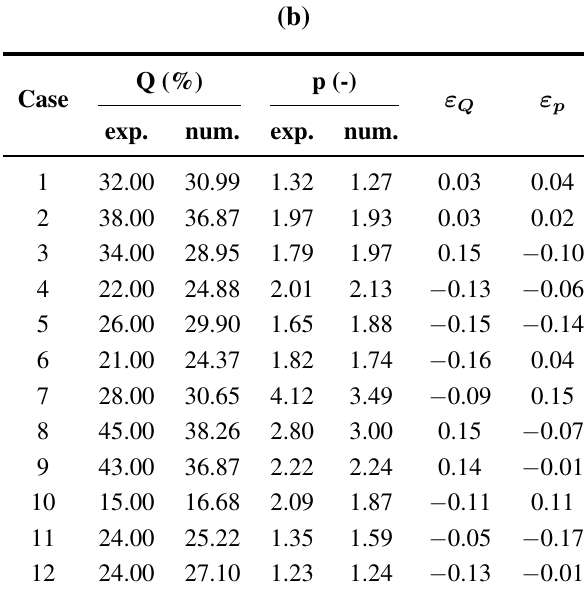
Figure 17. Specification of overtopping test cases. ( a ) Parameters; ( b ) tank and bund nomenclature [48]. Table 3. Simulation parameters and results. ( a ) Simulation parameters in accordance with the tank spill experiments of [48]; ( b ) results of simulations in comparison to the tank spill experiments of